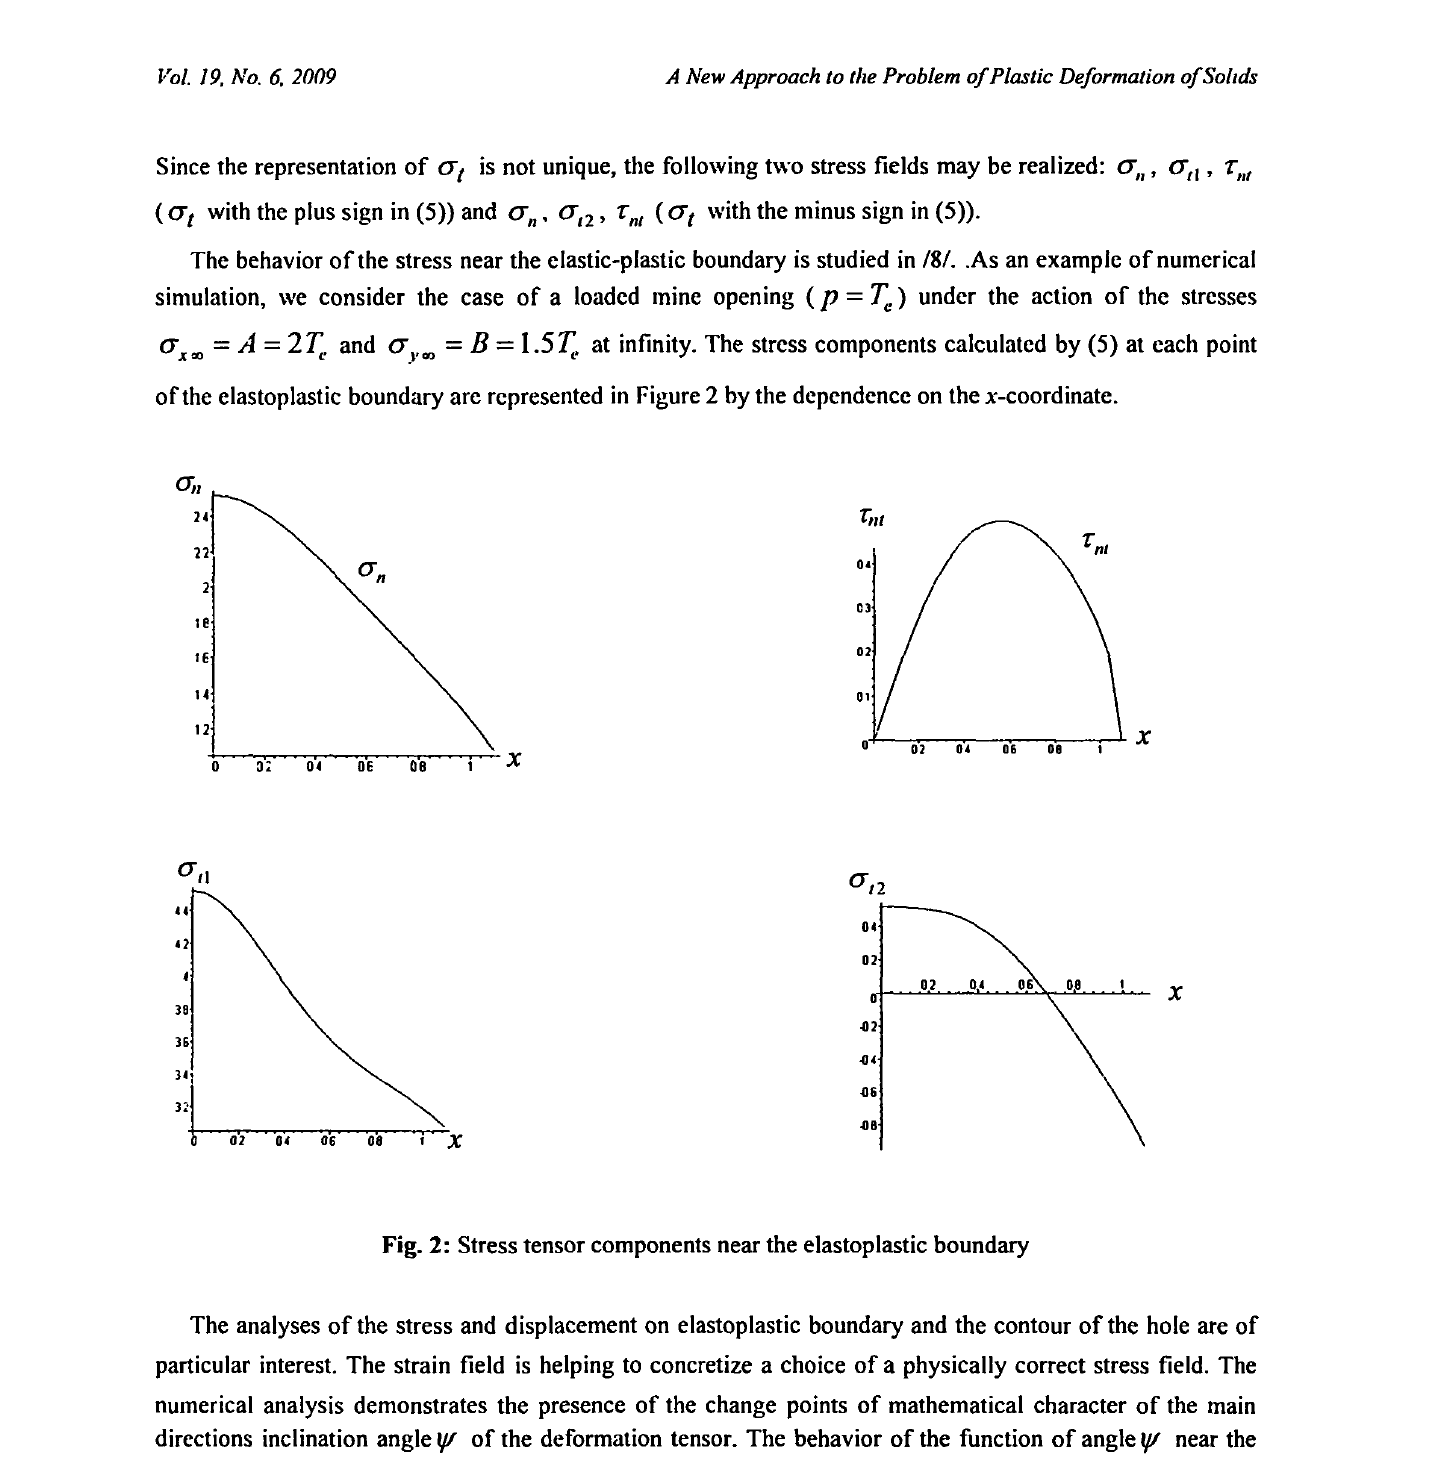
Fig. 2: Stress tensor components near the elastoplastic